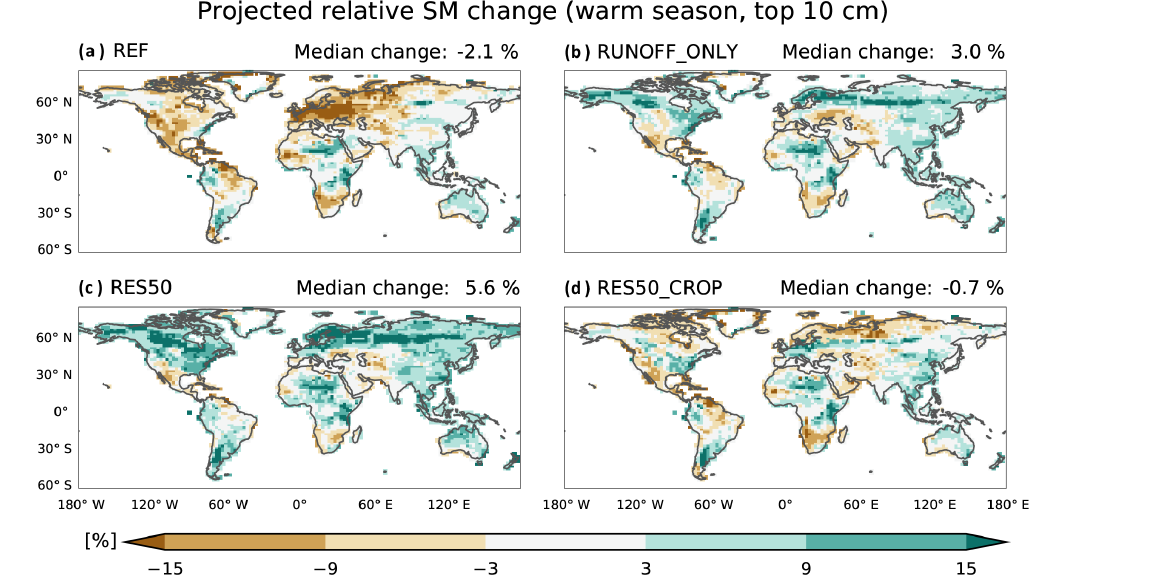
Figure 2. Projected change of SM in the topmost 10cm of the soil relative to the soil moisture climatology (1971 to 2000) in REF. Only the warm season (3 hottest consecutive months) is considered (Fig. S1).